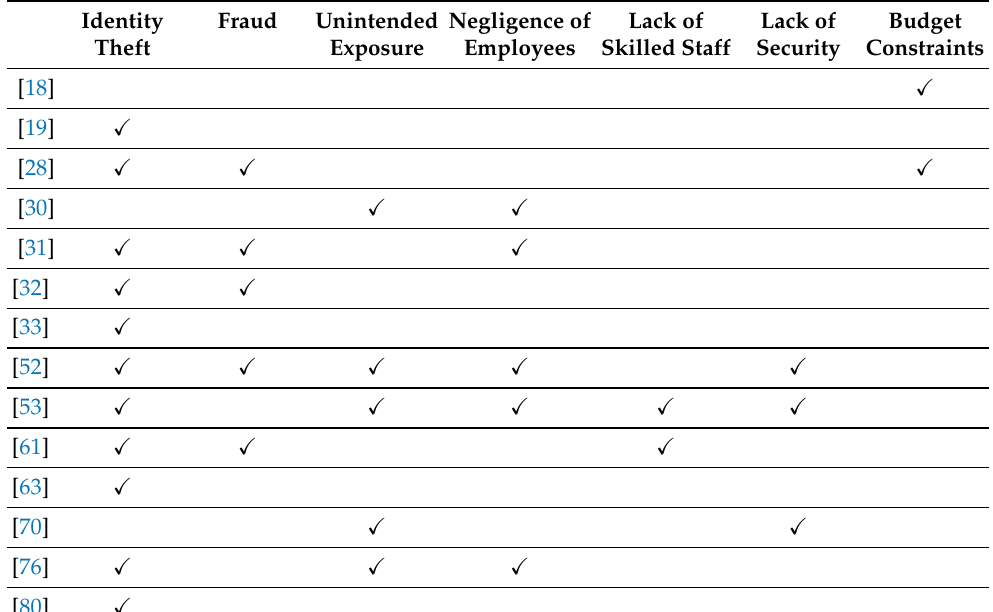
Table 5. Reasons contributing to the loss of information. Identity Fraud Unintended Negligence of Lack of Lack of Budget Theft Exposure Employees Skilled Staff Security